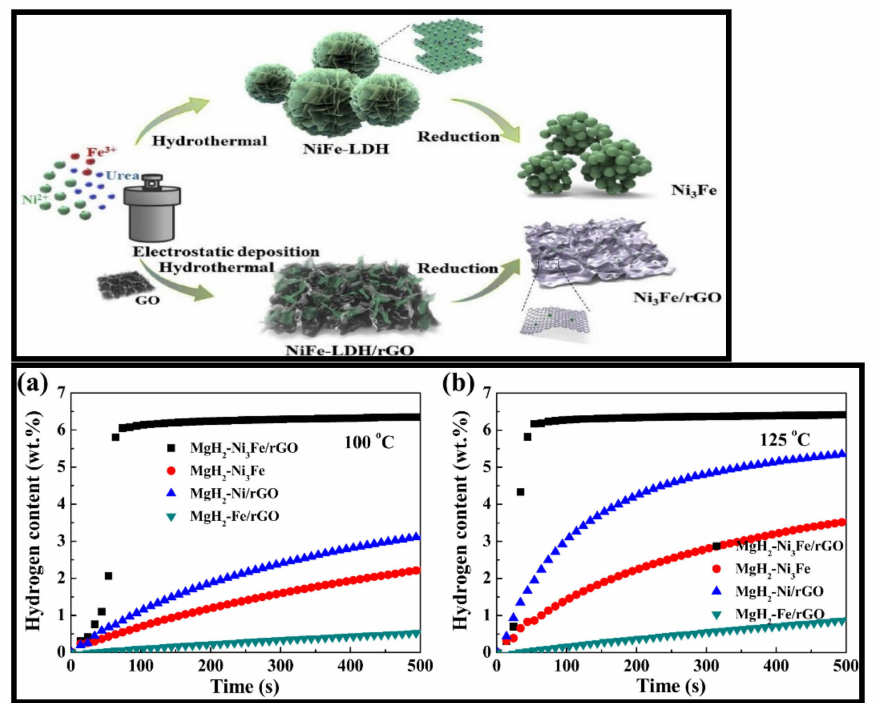
Figure 21. Synthesis procedure for the Ni 3 Fe and Ni 3 Fe/rGO. The strong electrostatic effect between GO and LDH results in the formation of a load structure rather than a flower shape ( upper panel ). Isothermal rehydrogenation curves of MgH 2 -5 wt% Ni 3 Fe/rGO, MgH 2 -5 wt% Ni 3 Fe, MgH 2 -5 wt% Ni/rGO and MgH 2 -5 wt% Fe/rGO at 100 ◦ C ( a ) and 125 ◦ C ( b ) under 3.0 MPa hydrogen pres- sure [161]. (Reprinted with permission from